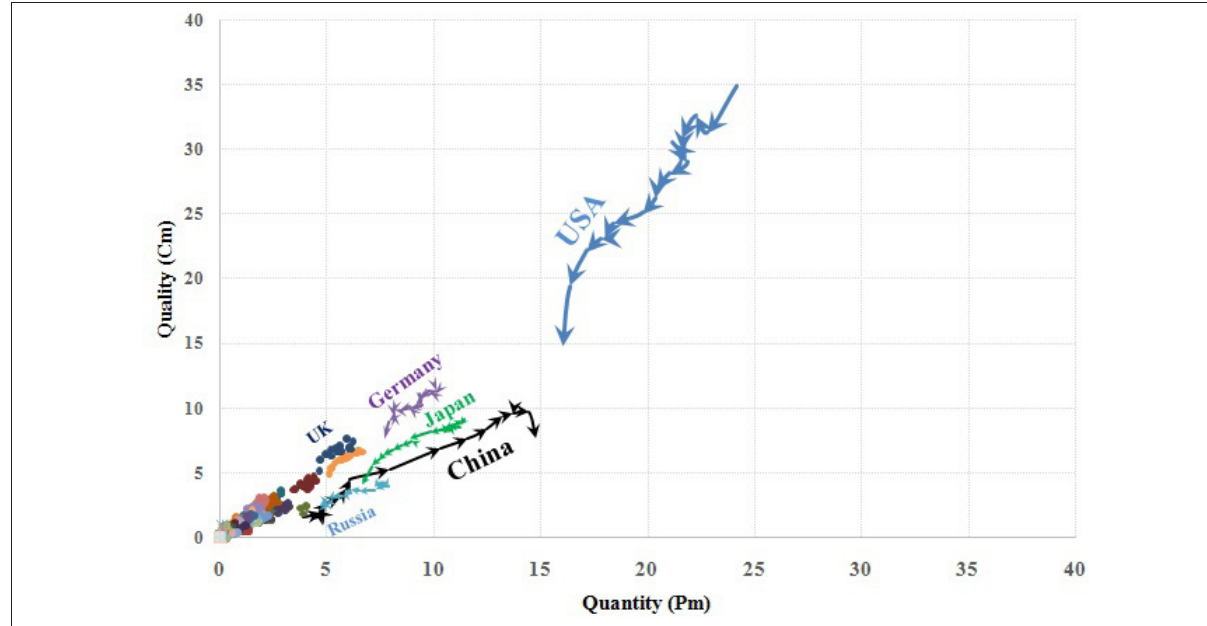
Figure 3: Two-dimensional diagram for most active countries, including